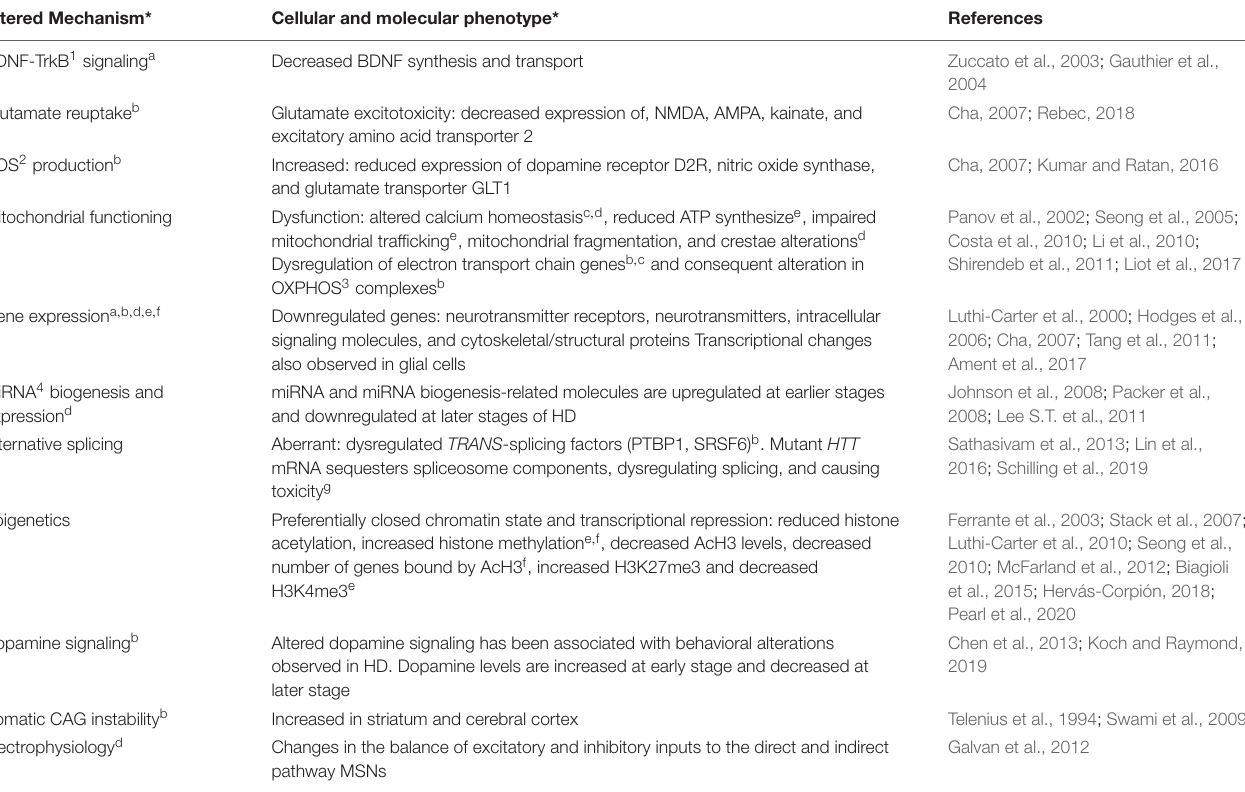
TABLE 1 | Pathogenic mechanisms correlated with striatal degeneration in Huntington’s